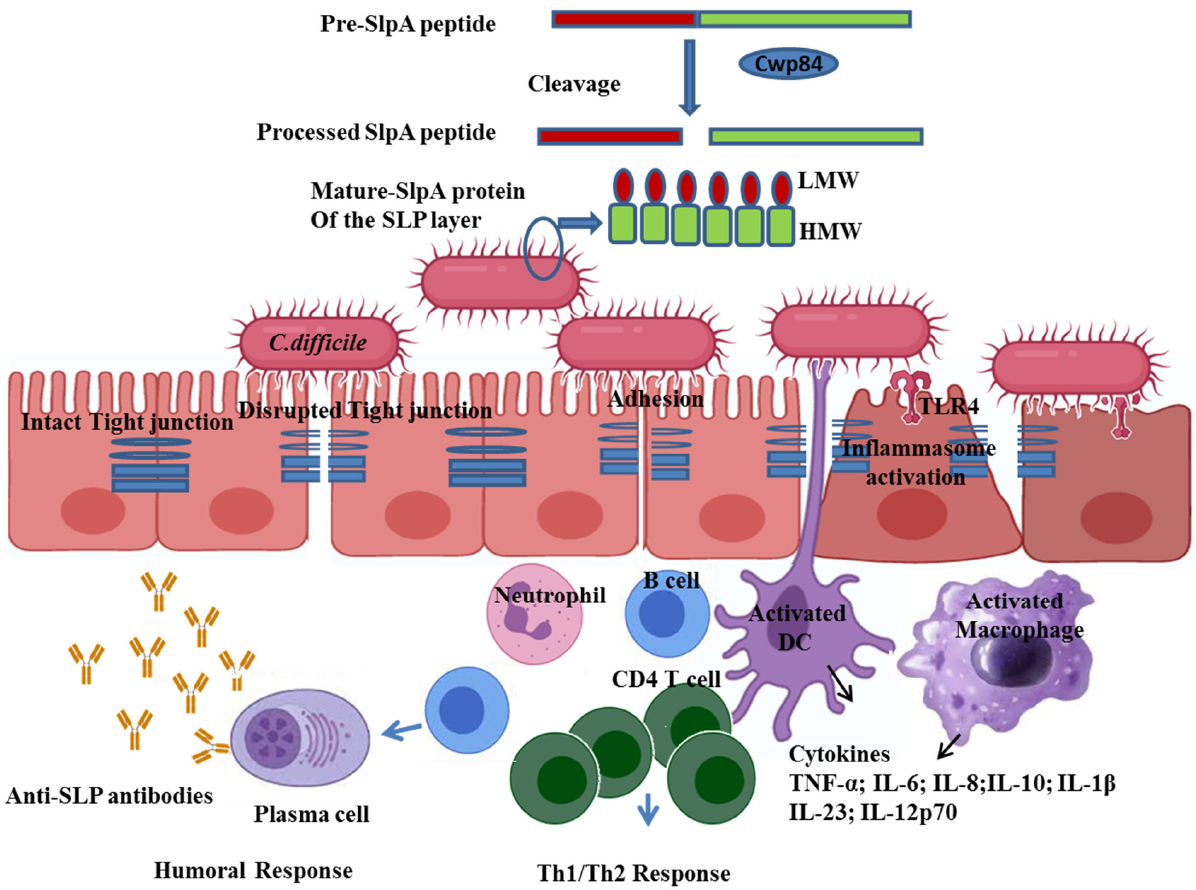
Figure 1. The SLPs of C. difficile mediate the adhesion and activation of the immune cells. Nascent SlpA peptide is cleaved by the protease Cwp84 into the LMW and HMW subunit, which forms the mature SlpA complex of the SLP layer of the cell wall [31–33]. SLPs mediate adhesion via TLR4 and disrupt the tight junction of the intestinal epithelial cells and further activate dendritic cells/macrophages, which in turn produce various cytokines and chemokines leading to the induction of Th1/Th2 and humoral response [9,27]. Interleukin (IL), Dendritic cells (DC), Low molecular weight (LMW), High molecular weight (HMW), Toll-like receptor 4 (TLR4).